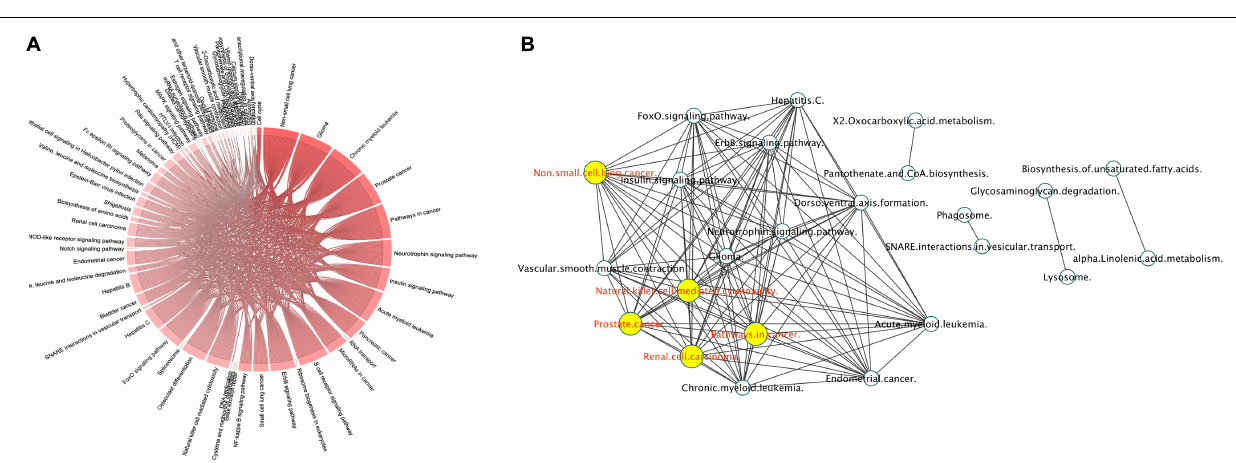
regulation, with their interactions, revealing how this pathway can be modulated by γ - valerolactones. Some genes involved in focal adhesion are regulated by miRNAs and lncRNAs, such as Integrin beta (ITGB), found in protein, mRNA, and